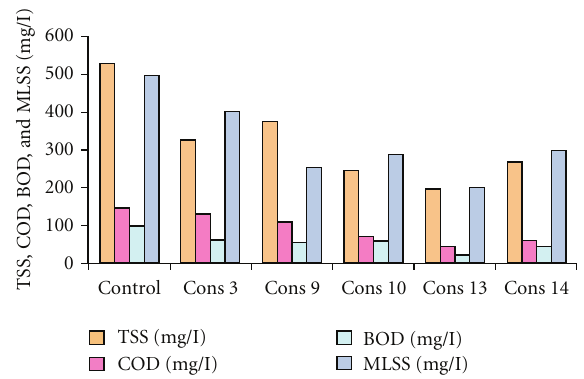
Figure 3: Comparison of TSS, COD, BOD, and MLSS of five selected